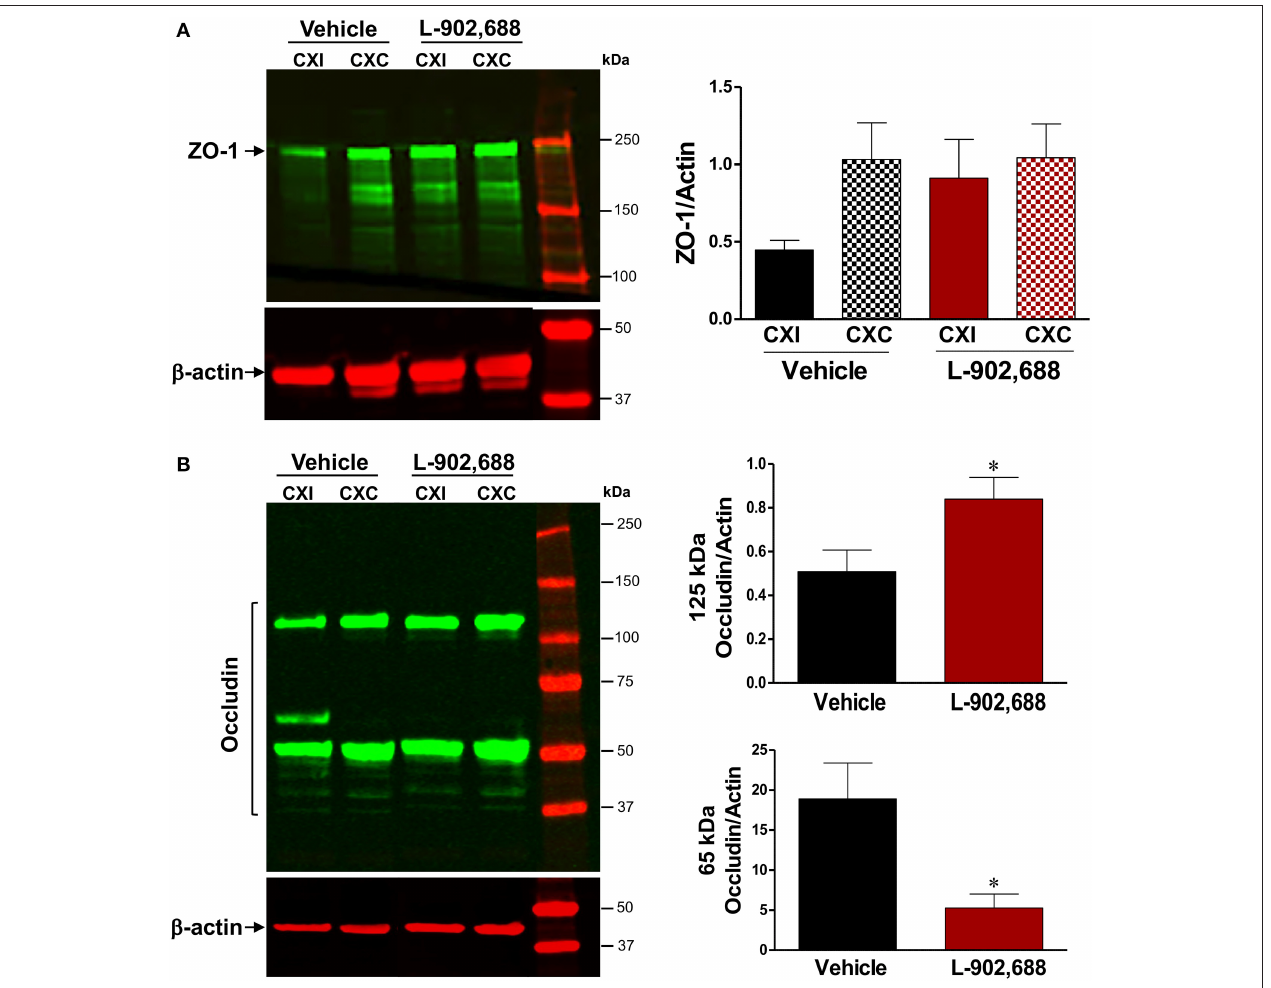
FIGURE 5 | Effect of L-902,688 on Tight Junction Proteins. We performed immunoblots to measure (A) ZO-1 in vehicle ( n = 10) and L-902,688 ( n = 8) groups and found a non-significant trend toward ZO-1 preservation in the ipsilateral hemisphere of the treated group compared to the vehicle in cortical samples. (B) Degradation of the dimeric form of occludin ( ∼ 125 kDa) was reduced in the ipsilateral cortex of L-902,688 and this was associated with decreased induction of the low molecular weight occludin ( ∼ 65 kDa). Data are reported as ipsilateral divided by contralateral due to the wide variability in the occludin content in both the contralateral and the ipsilateral hemispheres of vehicle-treated rats. CXI, ipsilateral cortex; CXC, contralateral cortex; STI, ipsilateral subcortex; STC, contralateral subcortex. * P < 0.05 compared with vehicle-treated